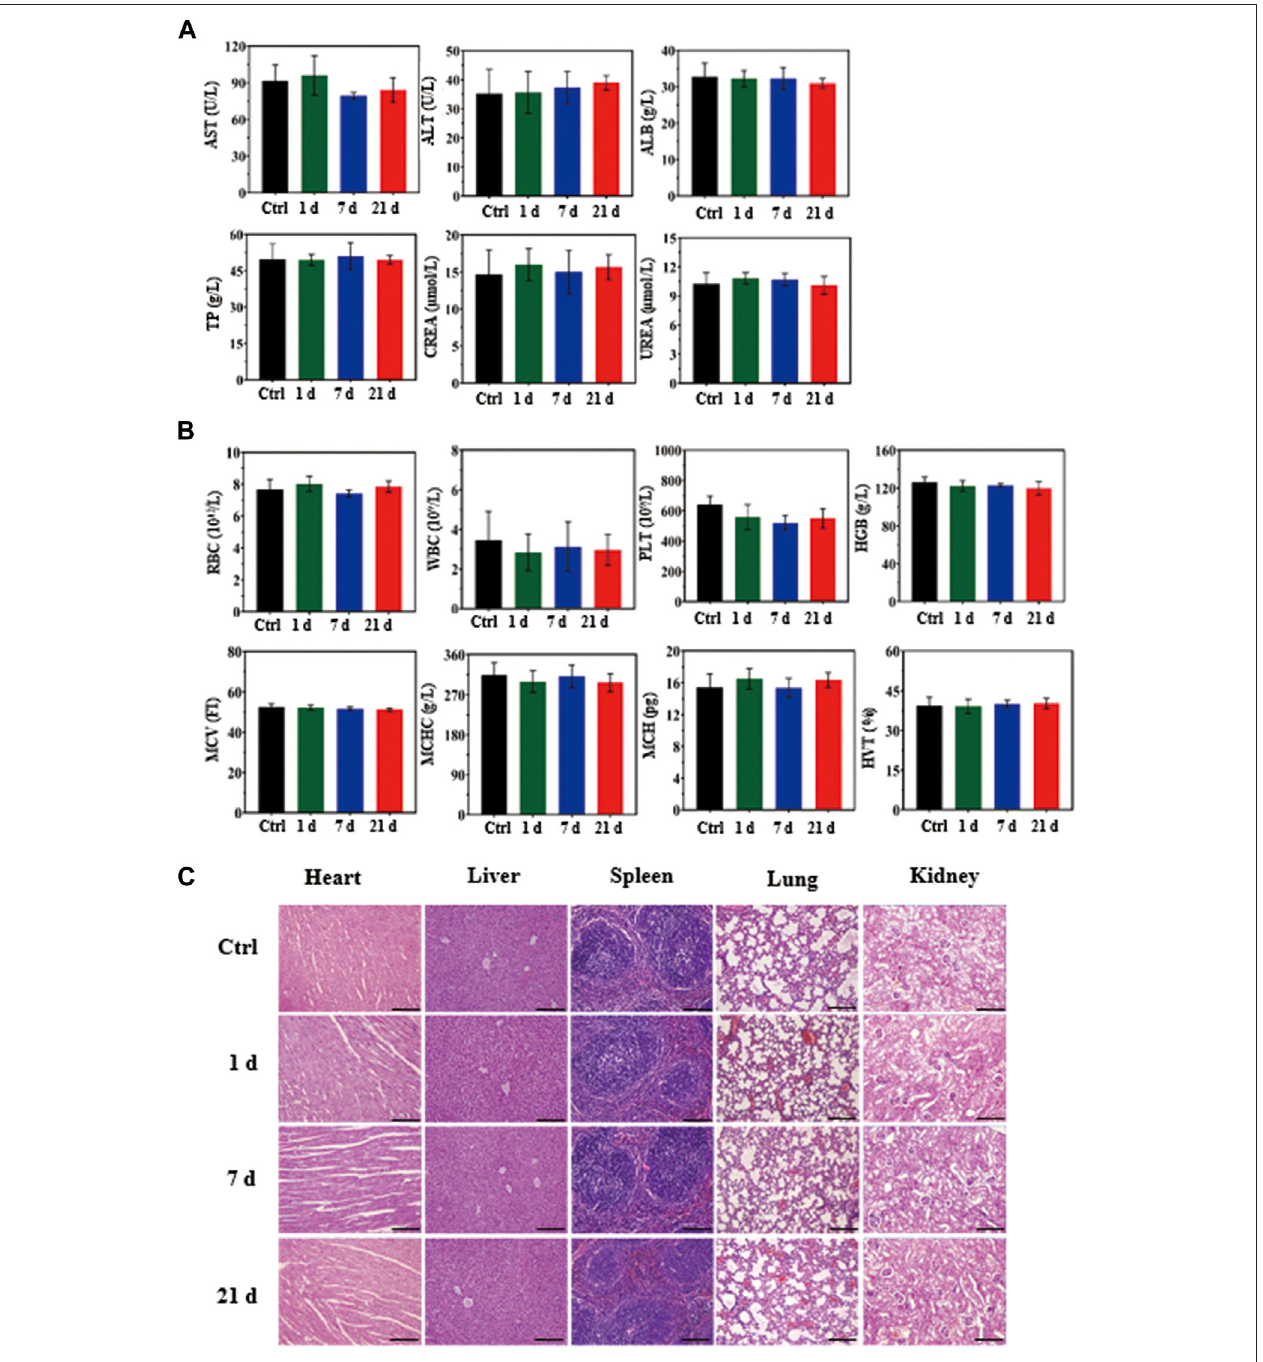
FIGURE9| Invivo biosafety assayofMCPMNPs(10 mg/kg). (A) Biochemicalanalysisofmouseserum before(control,day 0)andafter injection ofMCPMNPsfor days1,7,and21. (B) Histologicalimagesoftheheart,liver,spleen,lungs,andkidneysfromhealthymiceinjectedwithMCPMNPsatdays1,7,and21,andcontrolmice. The visceral sections underwent staining with hematoxylin and eosin (H and E) and observation under an optical microscope, scare bar (cid:2) 100 μ m.